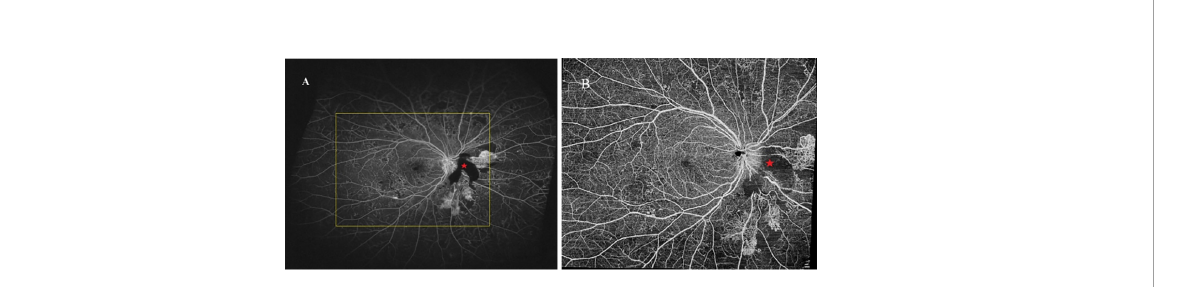
FIGURE 3 UWFFA (A) and WF SS-OCTA (B) posterior pole montage of a representative eye. UWFFA performed by Optos Optomap Panoramic 200Tx imaging system with the yellow square indicated the same FOV of WF SS-OCTA obtained by VG200, SVision Imaging system. The area noted with red pentagram was caused by funds